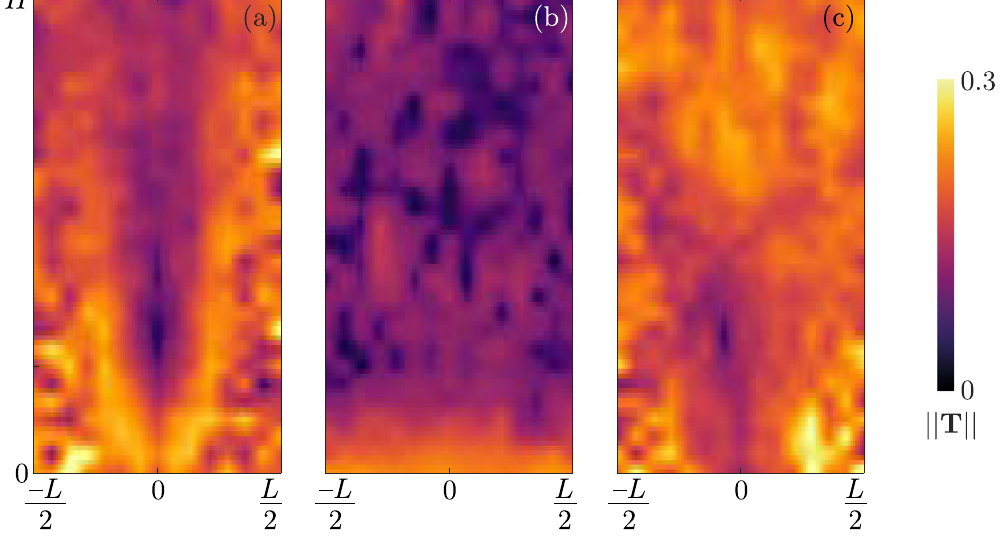
Figure 8. Order parameter field for ( a ) jasmine rice, ( b ) glass beads, ( c ) red lentils, for the case of D = 10 mm opening.